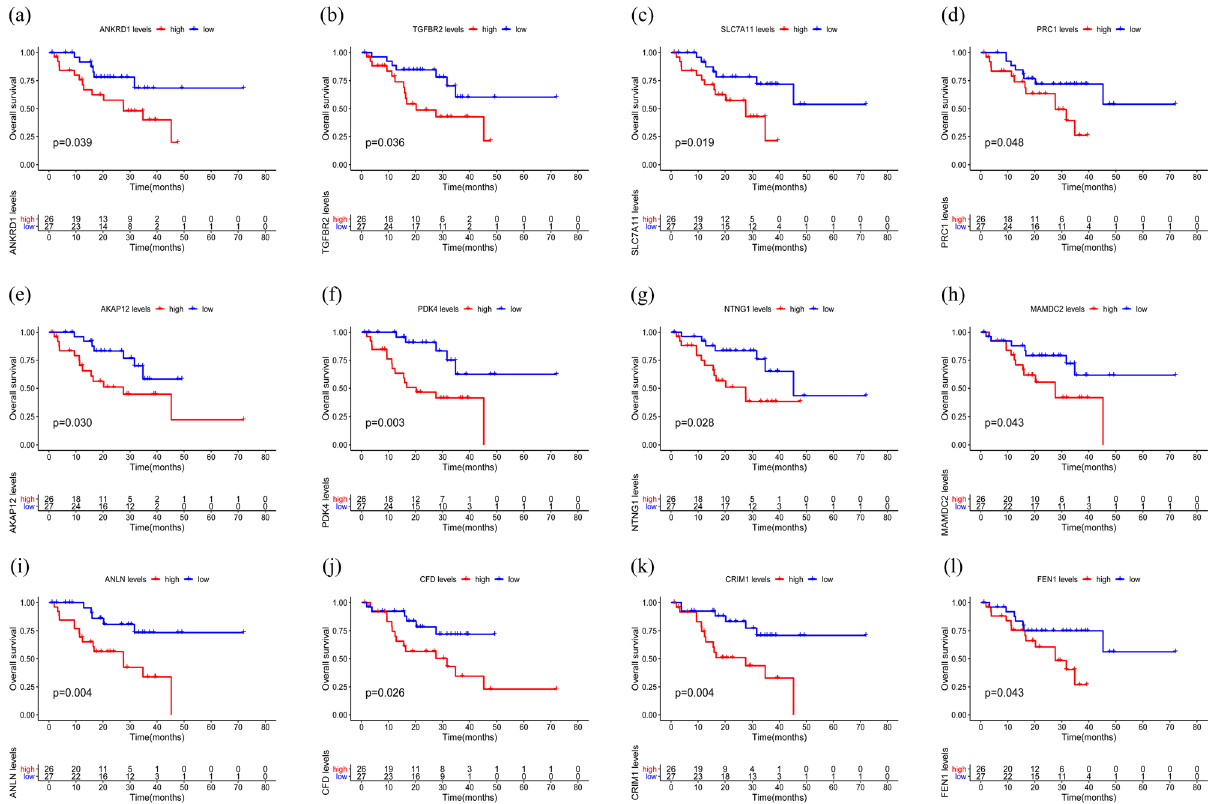
Figure 6: The Kaplan - Meier curve of 12 up - regulation genes in youth - onset NSCLC a ff ect overall survival.